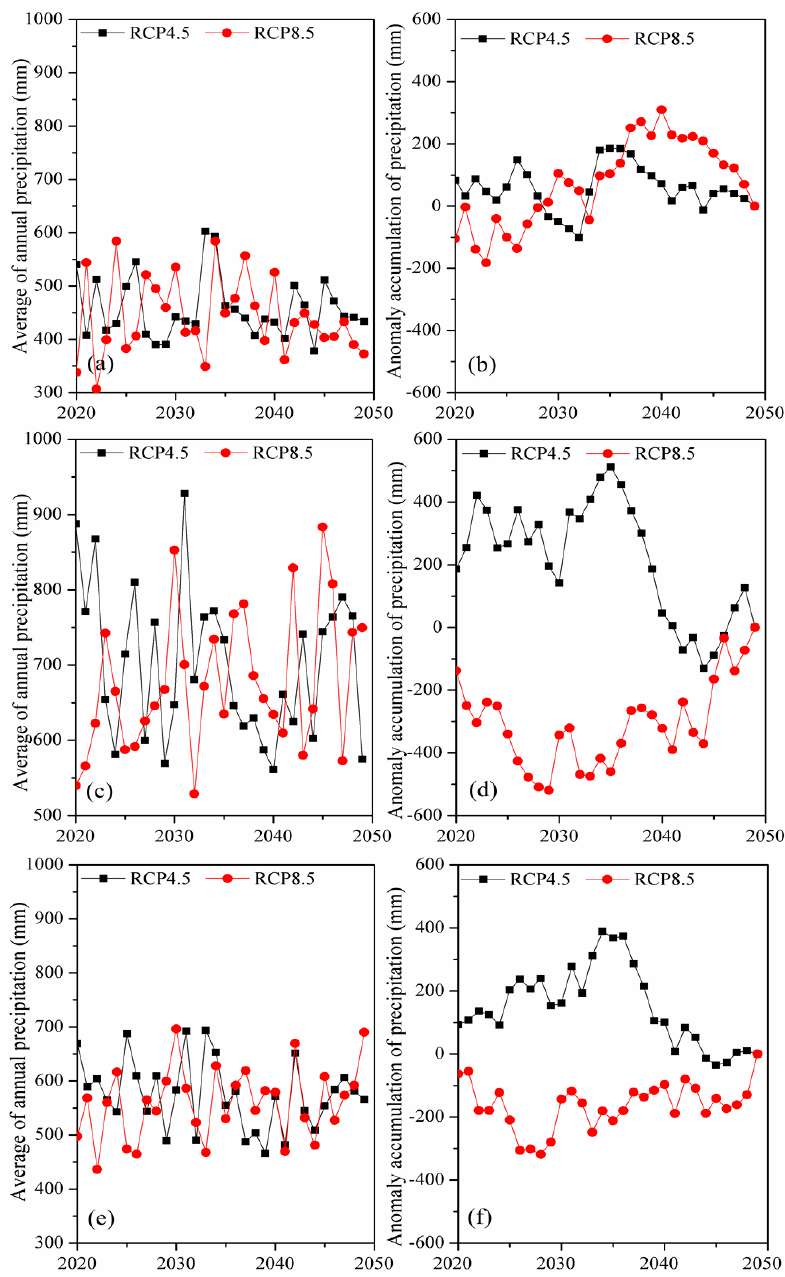
Figure 6. Inter ‐ annual variation and anomaly accumulation of precipitation in the Nenjiang River ( a , b ), Upper Songhua River ( c , d ), and Lower Songhua River ( e , f ) sub ‐ basins of the Songhua River Basin during